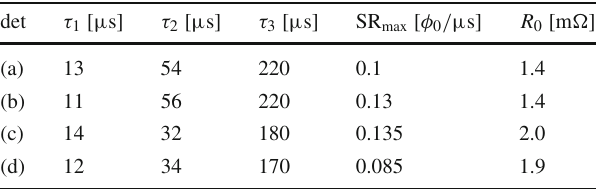
Table 3 Exponential time constants obtained by fitting the pulses due to the chlorine X-rays ( ≈ 2.6 keV) on the rising ( τ 1 ) and falling ( τ 2 and τ 3 ) edge of the pulses. The subscripts 2 and 3 refer to the two decay time constants which describe the two-body effect found in our detectors. The shorter values of τ 2 obtained with detectors c and d are due to the different working point chosen for the measurement. SR max is the maximum slew rate observed for pulses of this energy: this value must not be larger than 0.25 φ 0 / µ s, which is the maximum slew